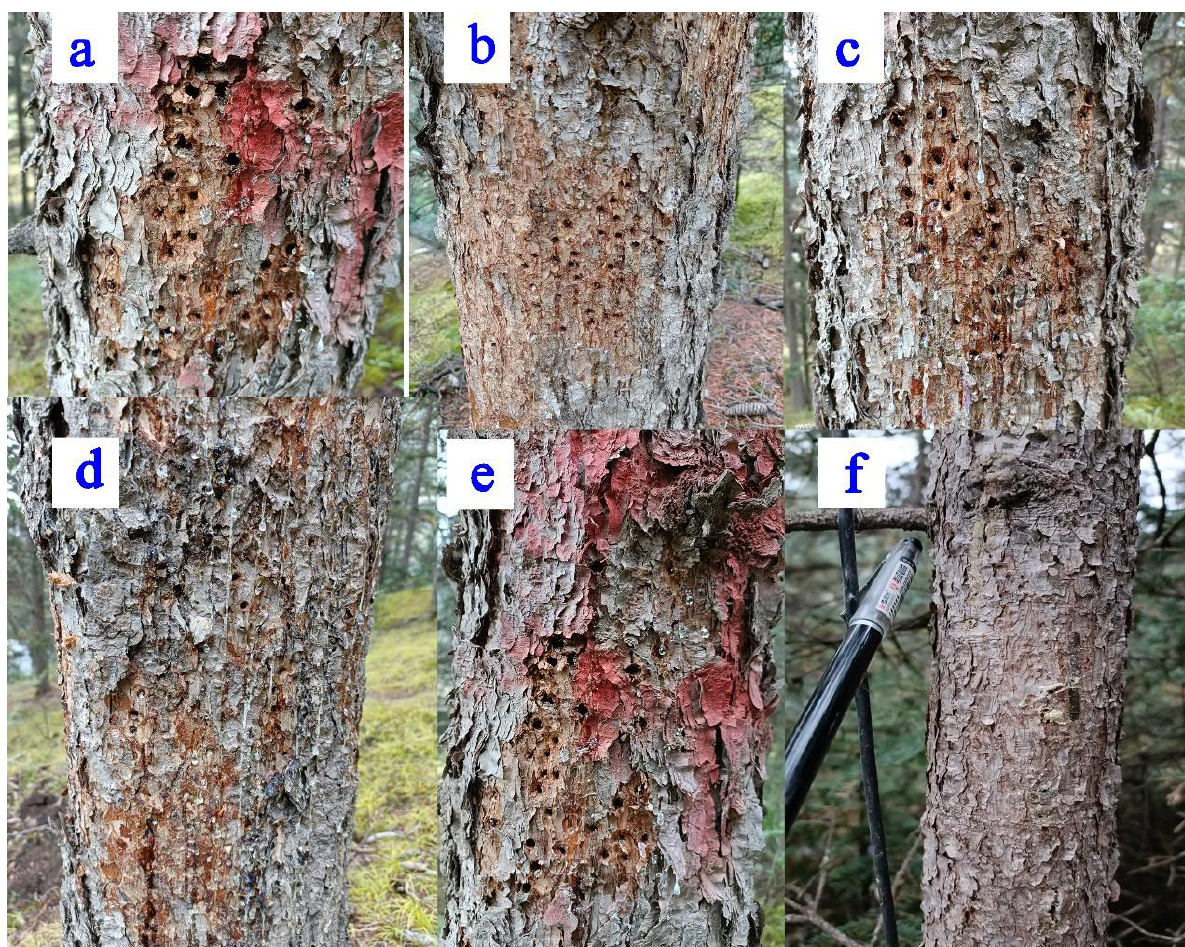
Figure 1. Tree wounds after several growing season observations in Qinghai spruce in the Qilian Mountains. ( a – f ) were six sample tress after multiple observation seasons.